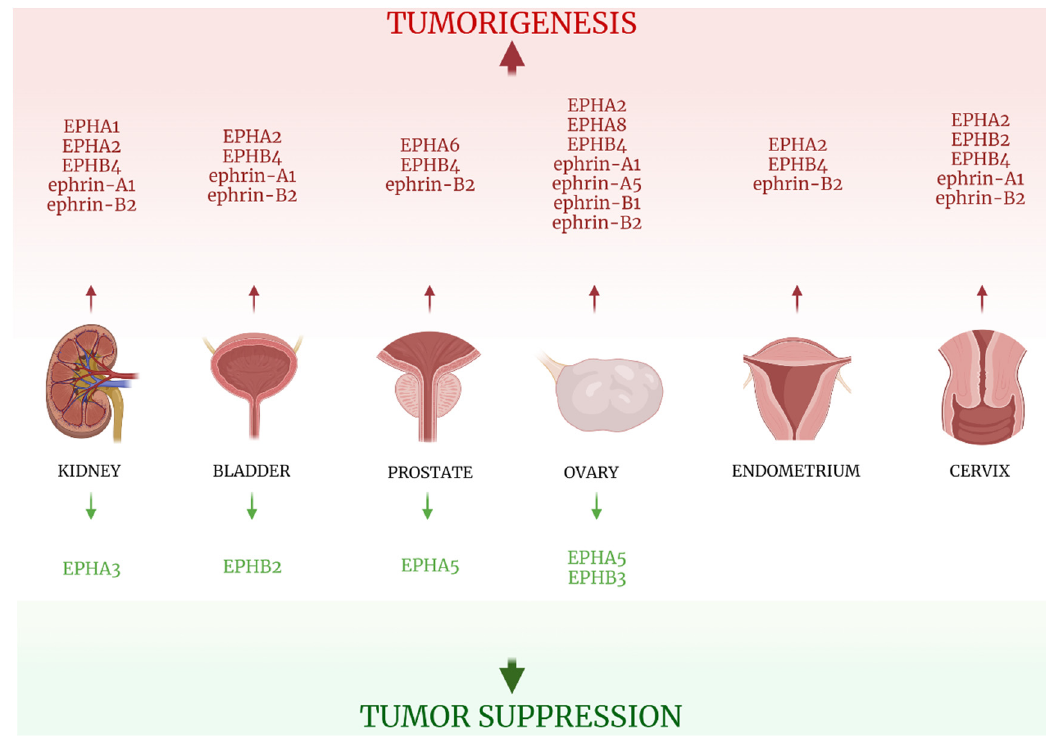
Figure 5. EPH/ephrin family role in solid tumors of organs of the urinary tract, prostate, and gynecological tract. Red- colored EPHs/ephrins enhance tumorigenesis, while green-colored ones suppress it. Created with BioRender.com (accessed on 2 August